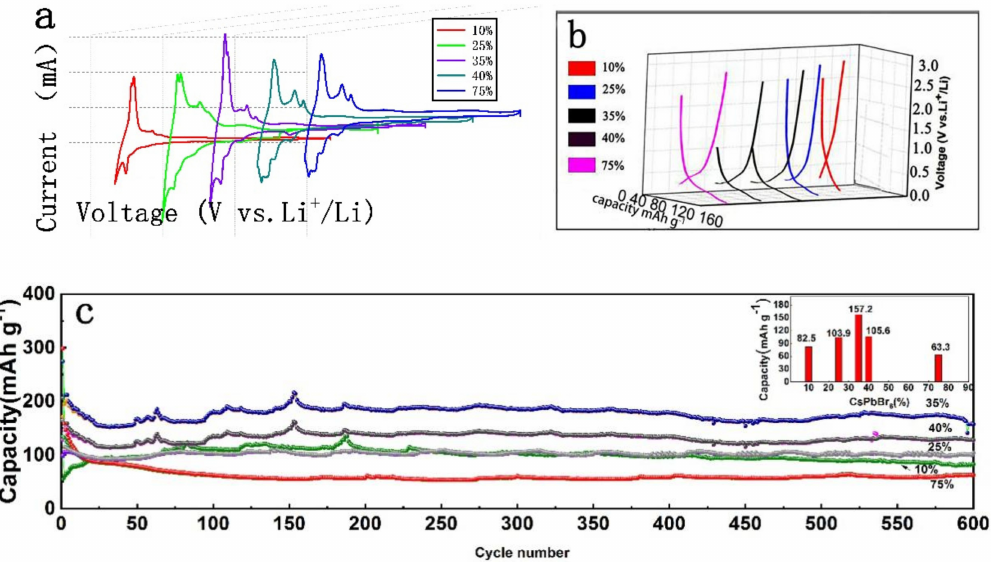
Figure 2. Electronic performance of 10%, 25%, 35%, 40%, 75% CQDs/G. CV of CQDs/G ( a ), the charge–discharge of CQDs/G ( b ) and the long cycle stability of CQDs/G ( c ).